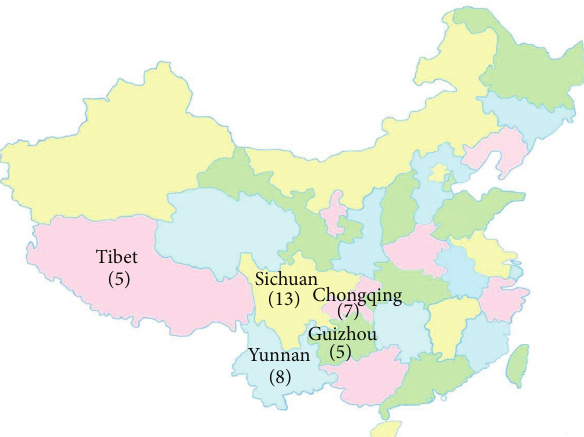
Figure 1: The collection sites of the 38 samples of wild C. dactylon in Southwest China. Provinces where samples were collected are illustrated with number of C. dactylon accessions in parentheses underneath in